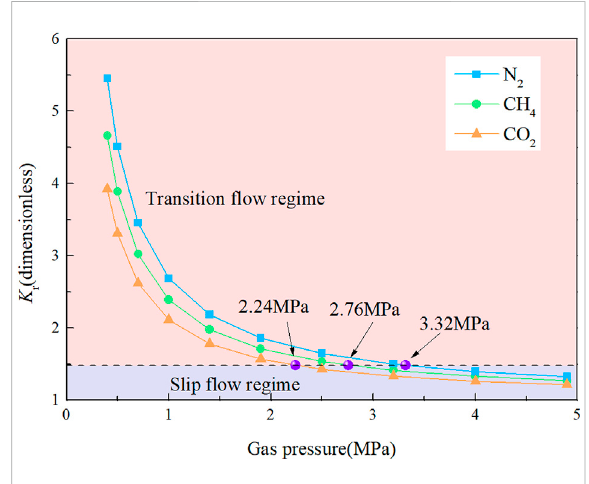
FIGURE 12 Variation in the dimensionless permeability coef fi cient with pressure P avg for different